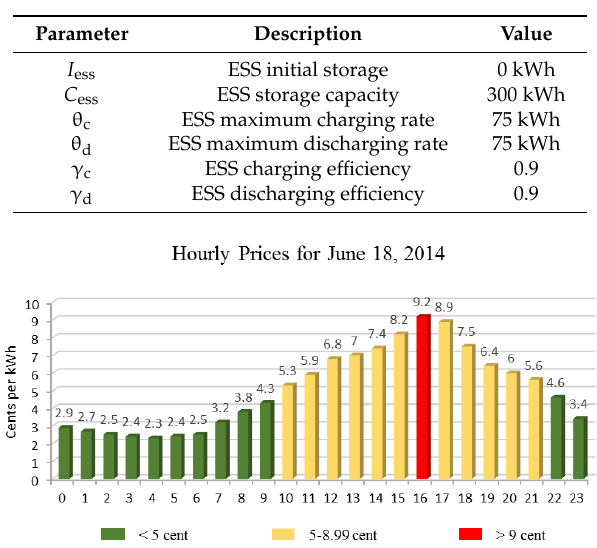
Figure 9. Day-ahead hourly electricity prices from Ameren Illinois for 18 June 2014. The prices can be classified into three types: low-price (green), high-price (yellow), and peak-price (red).